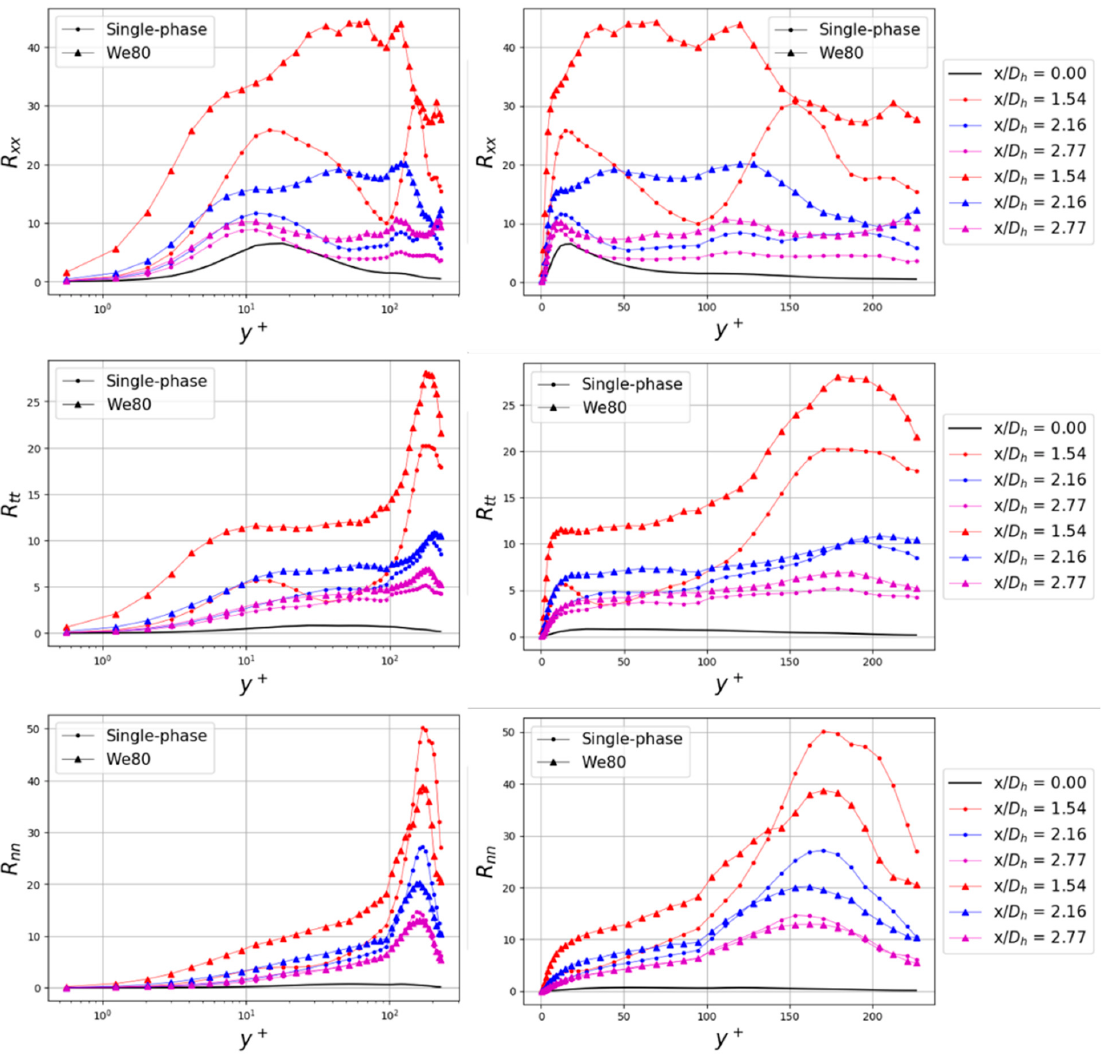
Figure 7. Comparison of downstream normalized Reynolds stress components for the We80 case with the single-phase simulation. Inlet profile (similar for both cases) is shown in solid black. Profiles at three downstream planes are shown for each case (lateral coordinates rotated to 𝑡 − 𝑛 system).